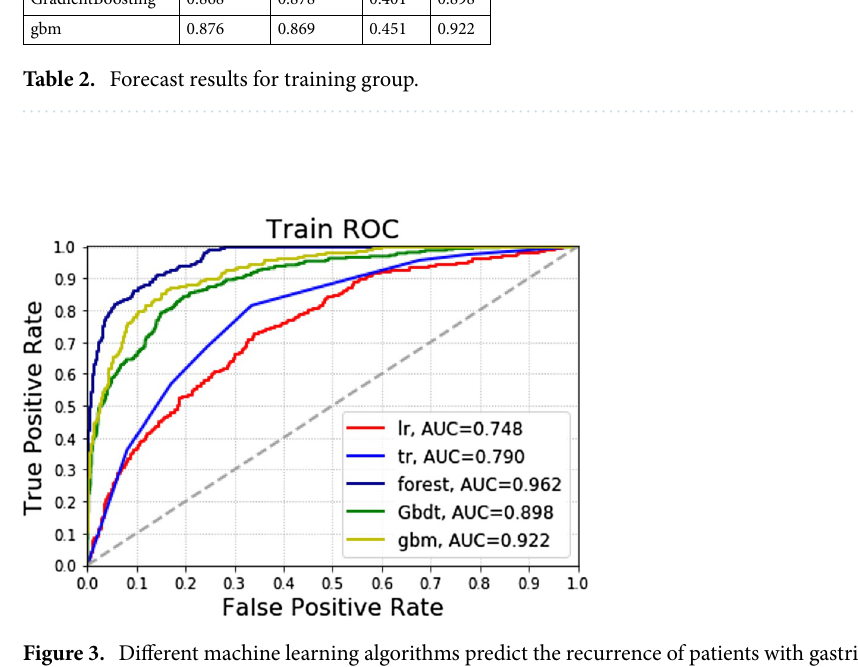
Figure 3. Different machine learning algorithms predict the recurrence of patients with gastric cancer after the operation in the training